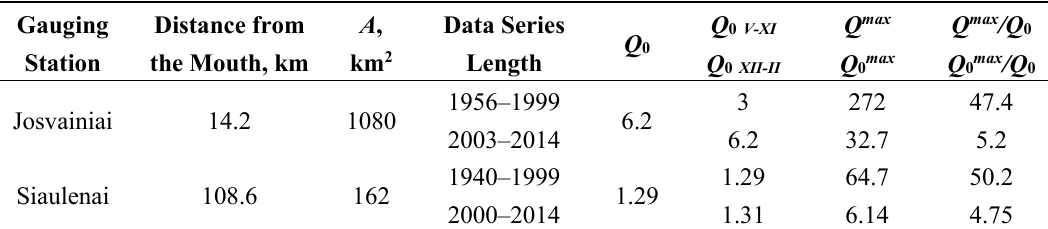
Table 4. Characteristic of the Susve River gauging